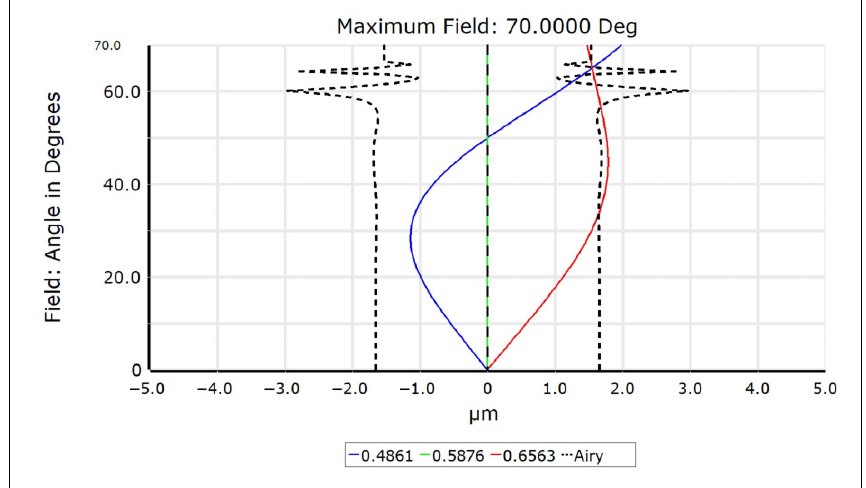
Figure 5. Lateral color of the optimized system.